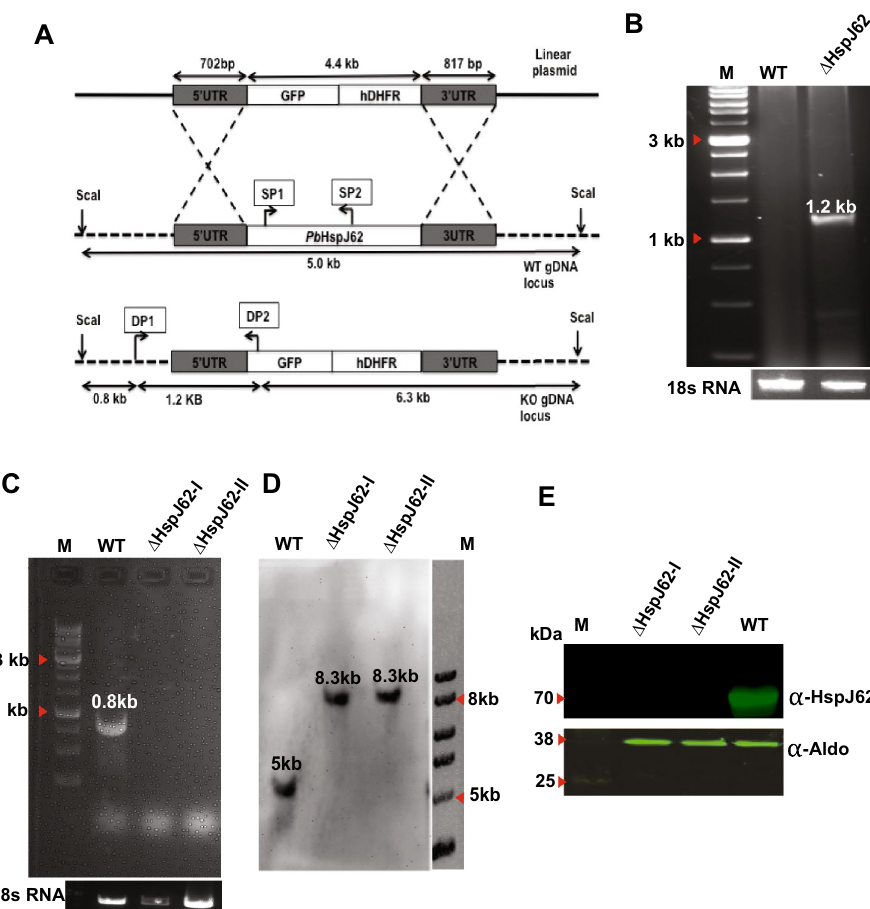
Figure 3. Generation and validation of the P. berghei HspJ62 knockout strain (ΔHspJ62). ( A ) The image shows the schematic summary of the HspJ62 gene knockout strategy by double homologous recombination using linearized vector-pBC-GFP-hDHFR-HSPJ62KO. The replacement cassette consisted of GFP and the hDHFR gene flanked by the 5’UTR (702 bp) and 3’UTR (817 bp) of the HspJ62 gene. ( B ) The expected product size of 1.2 Kb from diagnostic PCRs was observed. The external primer DP1 anneals to the chromosome, whereas DP2 is specific to the cassette. This primer pair shows specific band size 1.2 Kb only in the KO population. Full blots are shown in Supplementary Fig. 6A. ( C ) The two internal primers SP1 and SP2 anneal to the HspJ62 genomic locus. The PCR shows a specific band size of 842 bp only in the wild type and not in the knockout parasites. Full blots are shown in Supplementary Fig. 6B. ( D ) Southern blot analysis of ScaI-digested genomic DNA, obtained from WT and ΔHspJ62-I & II knockout parasite lines, using the 5’UTR of the HspJ62 gene as a probe resulted in the expected 5 Kb band corresponding to the WT gene and 8.3 Kb band corresponding to ΔHspJ62 parasite line. ( E ) Immunoblot analysis shows the absence of HspJ62 protein (62 kDa) expression in the ΔHspJ62-I & II parasite line compared with the WT parasite line. Pb- aldolase protein was used as a loading control. Full blots are shown in Supplementary Fig. 5F–H. WT wild type parasite lysate, ∆HspJ62-I and ∆HspJ62-II- are the parasite lysates from the two HspJ62 knockout parasite